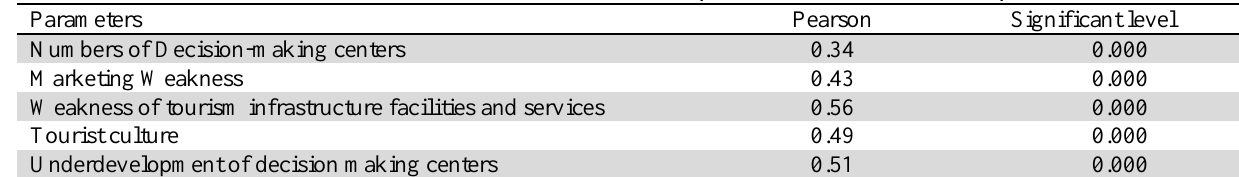
The results of Pearson correlation between different components and underdevelopment of tourism